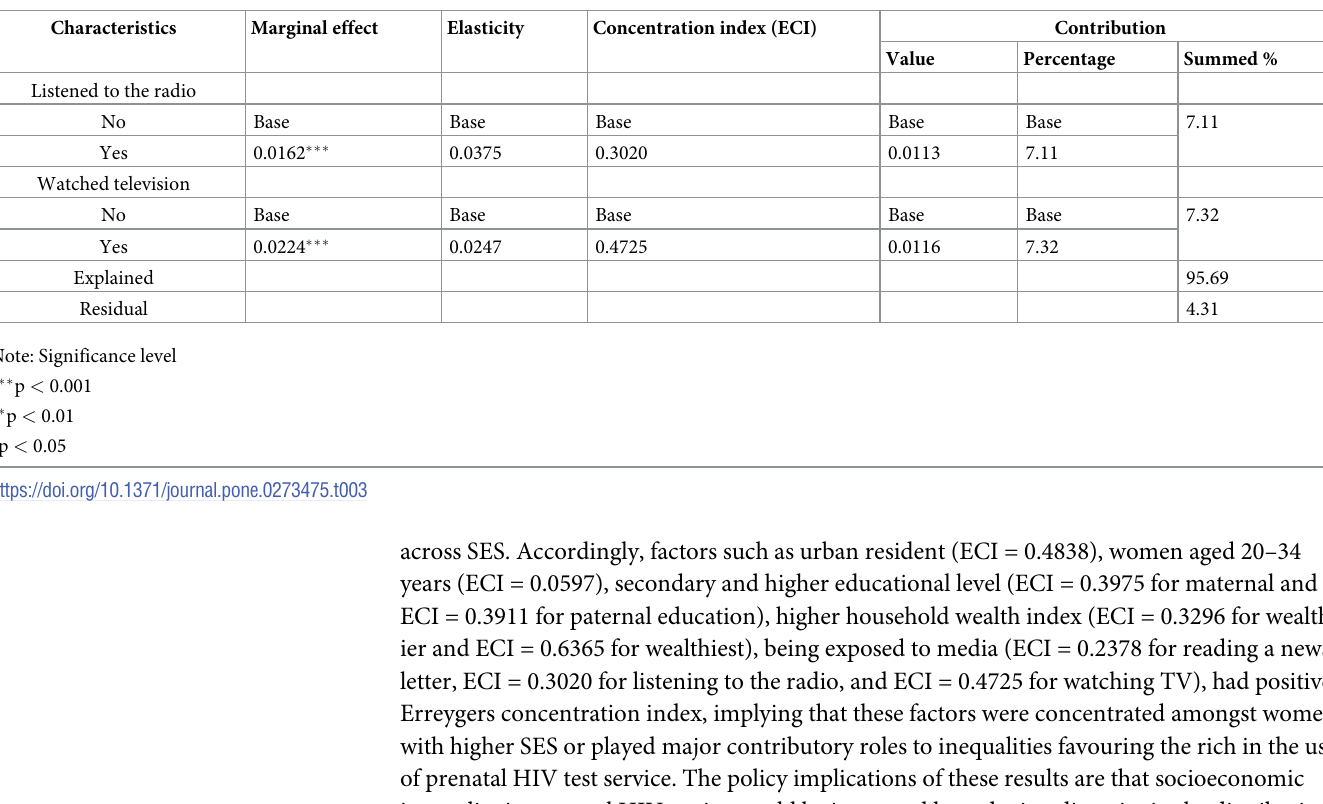
PLOS ONE | https://doi.org/10.1371/journal.pone.0273475 August 23,